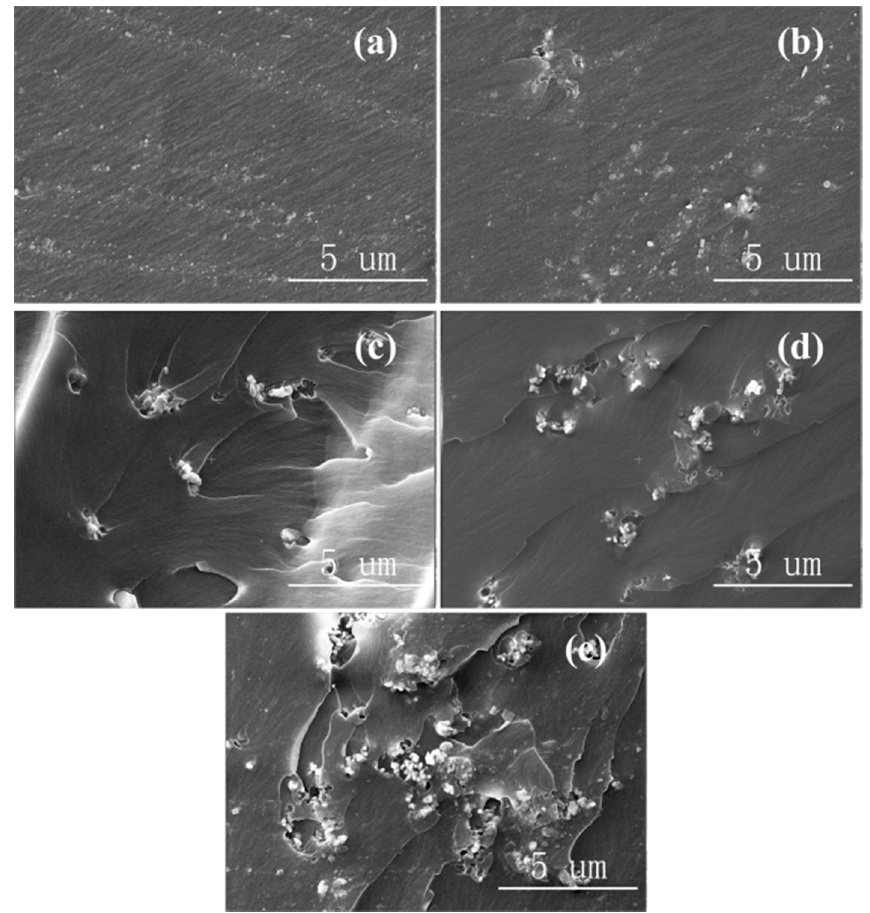
Figure 2. SEM images of Al 2 O 3 -NPs / epoxy resin composites with ( a ) 1 wt.%, ( b ) 3 wt.%, ( c ) 5 wt.%, ( d ) 7 wt.%, and ( e ) 10 wt.% of Al 2 O 3 filler.